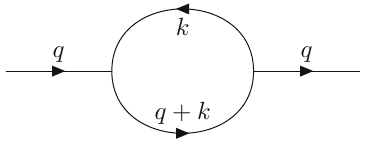
Fig. 1 Self energy diagram for a scalar field with mass